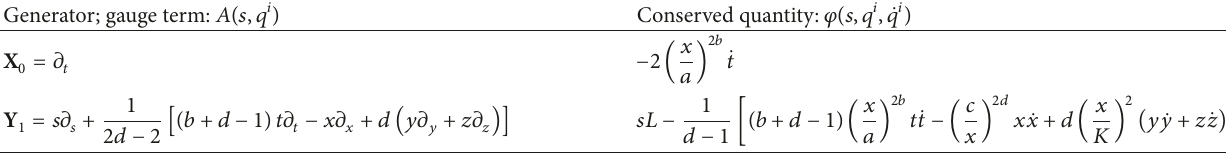
Table 39: Conserved quantities corresponding to each Noether symmetry.